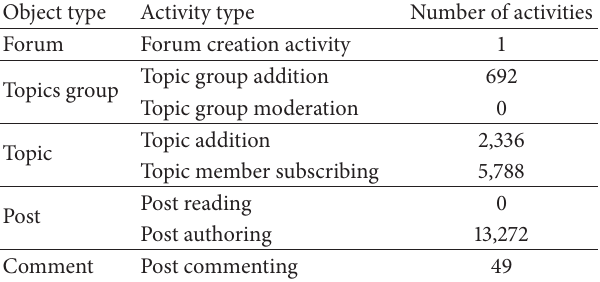
Table 2: Activities assigned to object